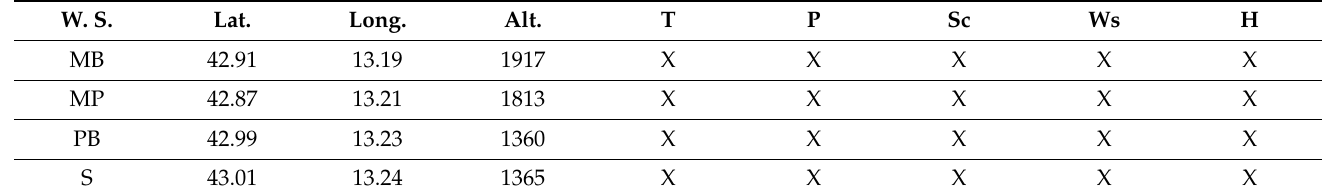
Table 1. Description of the weather stations (W.S.) analysed; latitude in WGS 1984 33 N (Lat.); longitude in WGS 1984 33 N (Long.); altitude in m a.s.l. (Alt.); for each weather station, an X under the corresponding sensor means that they are equipped with it and have data for the whole study period. Temperature (T), precipitation (P), snow cover (Sc), wind speed (Ws), relative humidity (H). W.